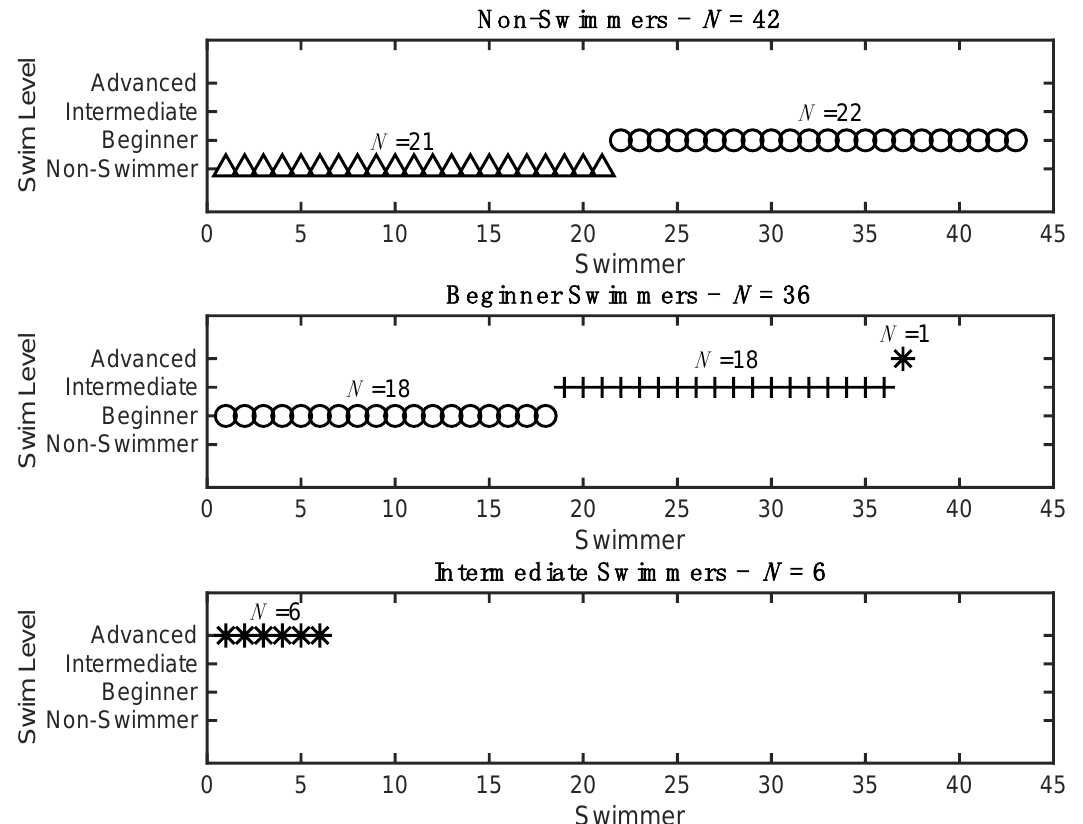
Figure 1. End swim level by start level. ( Top ) participants that started as non-swimmers, ( Middle ) participants that started as beginner swimmers, and ( Bottom ) participants that started as intermediate swimmers. Each participant is depicted as: x = non-swimmer, o = beginner swimmer, + = intermediate swimmer, and * = advanced. The number of participants in each category is indicated. Please note that two advanced swimmers remained at the advanced level at the end of the program, which is not depicted. Table 1. Linear mixed-effects regression estimates, standard error of the estimate, 95% confidence interval, T -statistic, degrees of freedom, and p